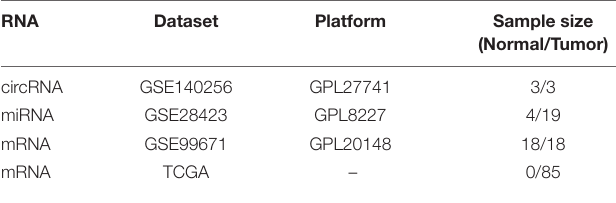
TABLE 1 | Basic information of the three microarray datasets from GEO and an RNAseq dataset from TCGA.